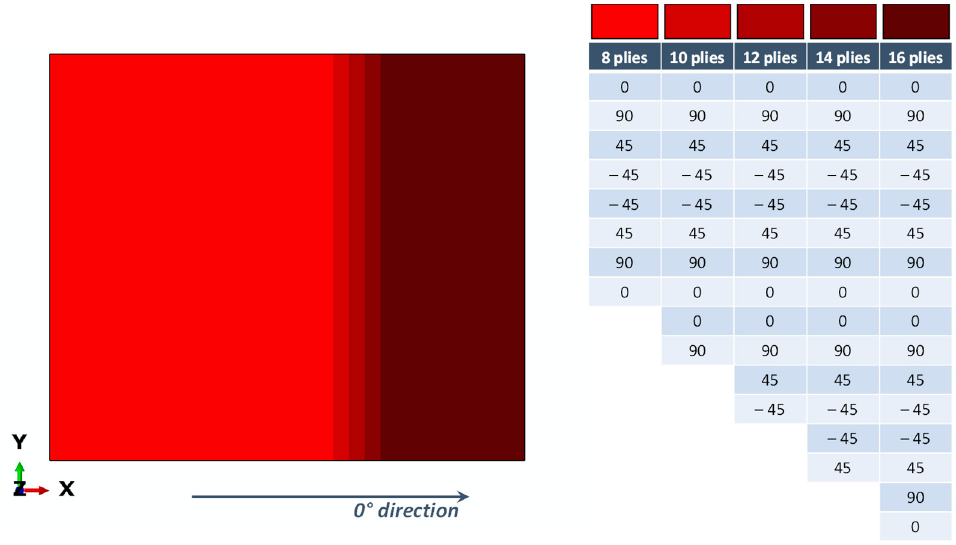
Figure 3. Stacking sequences in the skin.